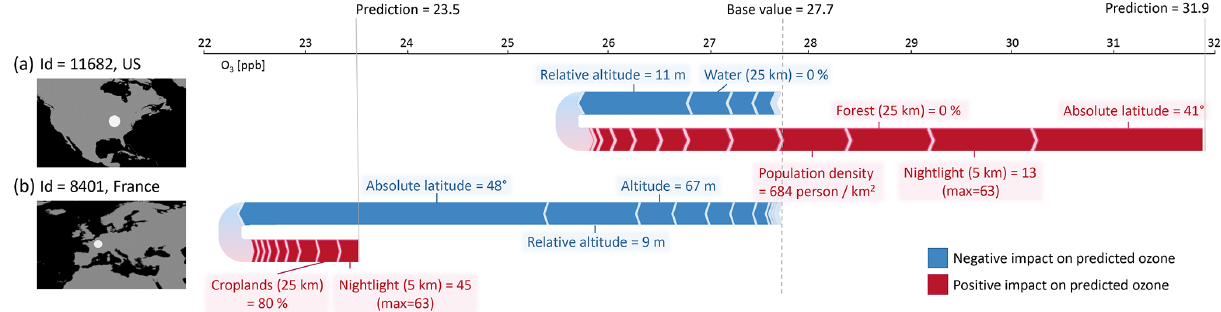
Figure E1. SHAP force plots for two example low-bias ( < 1ppb) predictions at (a) a rural station in the US and (b) an urban station in France, in addition to SHAP results from Sect. 3.1.3. Starting from the base value (27.7ppb), a feature can increase or decrease the predicted ozone (red and blue arrows). The final predictions (23.5 and 31.9ppb, respectively) result from adding all SHAP values to the base value. The most contributing features are labeled and their values are given. The high ozone station (a) is located in a rural area in the US with many agricultural fields and a smaller city nearby. The average ozone at this location is predicted to be high because the model uses the absence of forests, the low “nightlight in 5km area” value, and the “absolute latitude” as features leading to high ozone values. This is consistent with Fig. 5, where it can be seen that a lower “absolute latitude” often increases the ozone value. The French station (b) is an urban background station surrounded by fields. The location is further in the north than the US station which leads to a strong decrease in the predicted ozone value. The low “(relative) altitude” further decreases the predicted